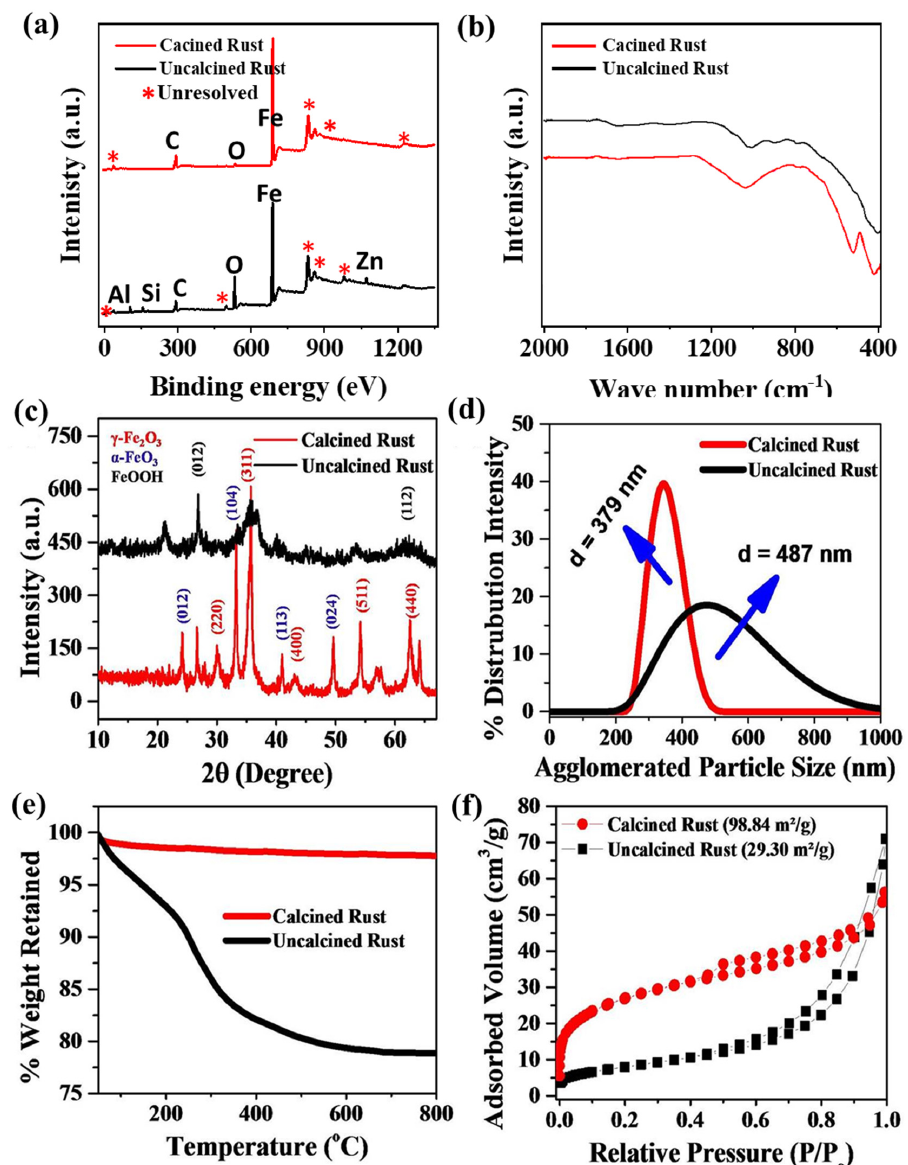
Figure 3. Chemical and structural analyses of uncalcined and calcined rust NPs. ( a ) XPS survey, ( b ) FTIR, ( c ) XRD patterns, ( d ) particle size distribution, ( e ) thermogravimetric analysis, and ( f ) BET surface area analysis of uncalcined and calcined iron rust.